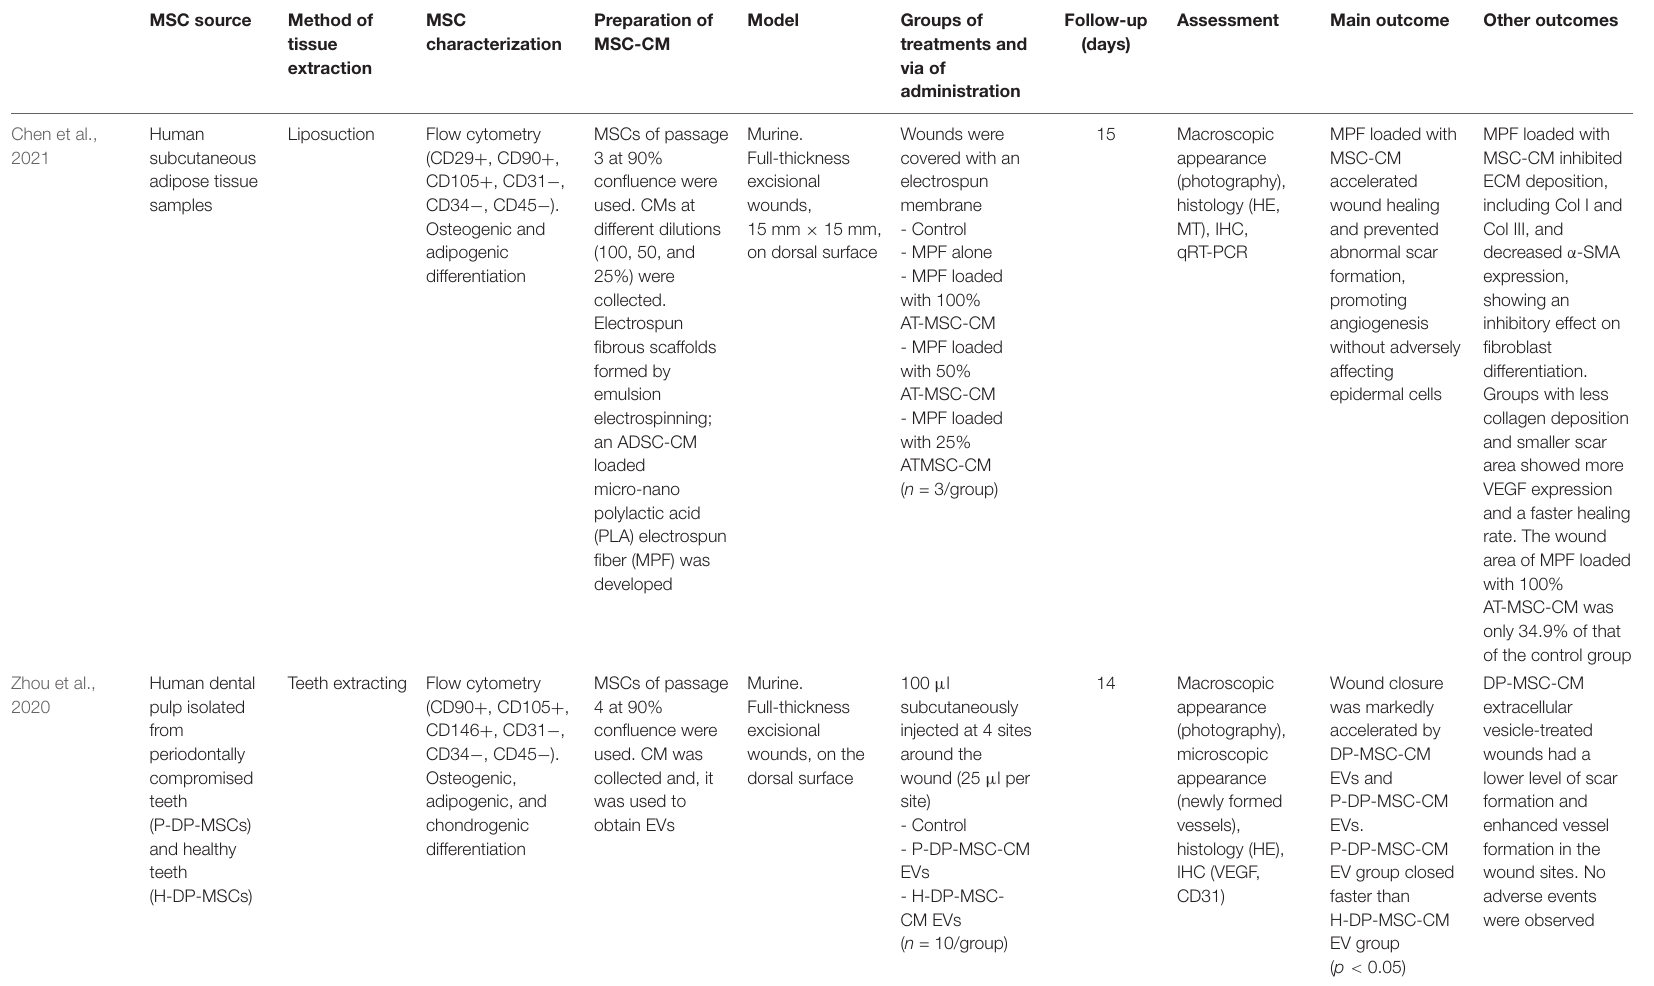
TABLE 1 | Studies regarding mesenchymal stromal cell-conditioned medium for treating wounds in animal